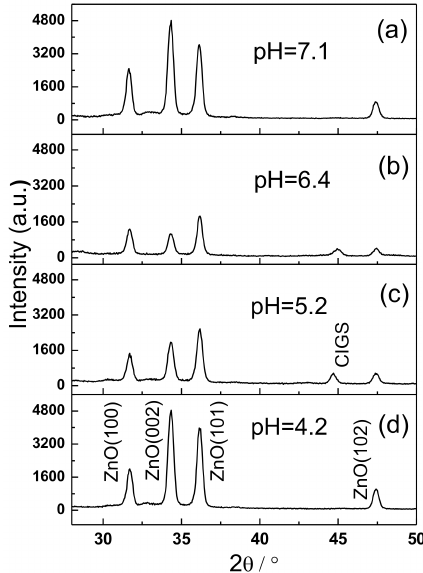
Figure 3. The XRD patterns of Cl-doped ZnO films that were electrodeposited using electrolytes with four pH values of ( a ) 7.1, ( b ) 6.4, ( c ) 5.2, and ( d )